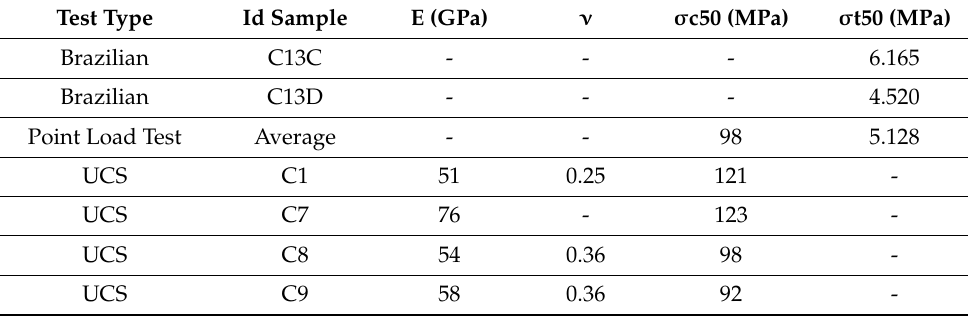
Table 4. Intact rock properties from new laboratory tests.